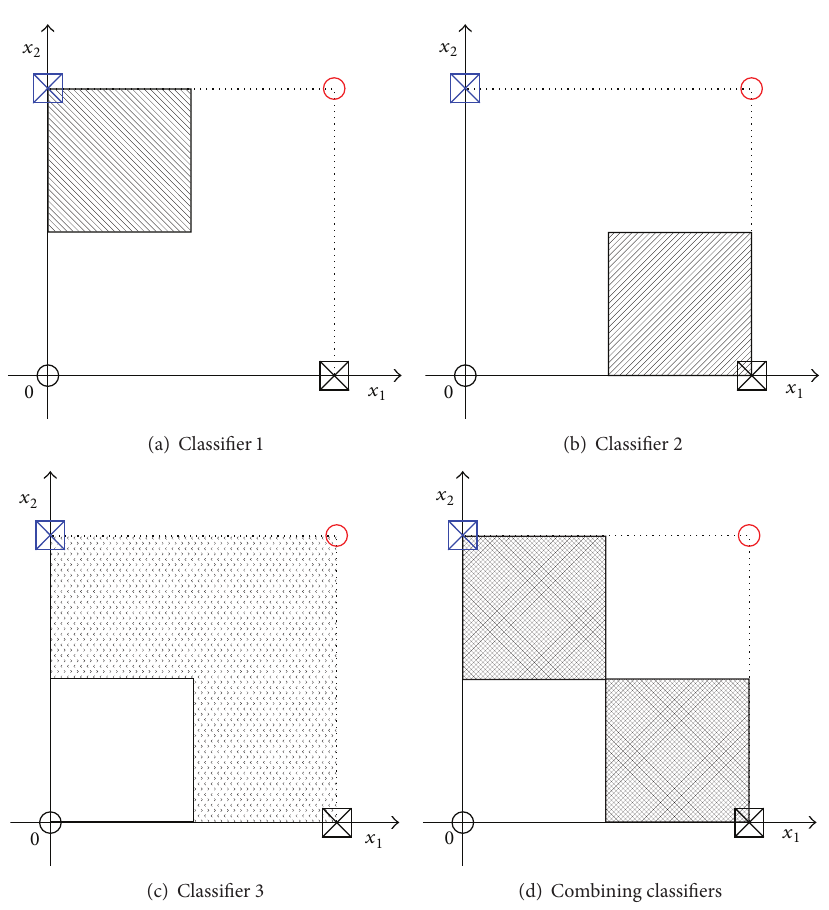
Figure 5: The XOR problem solved by combining